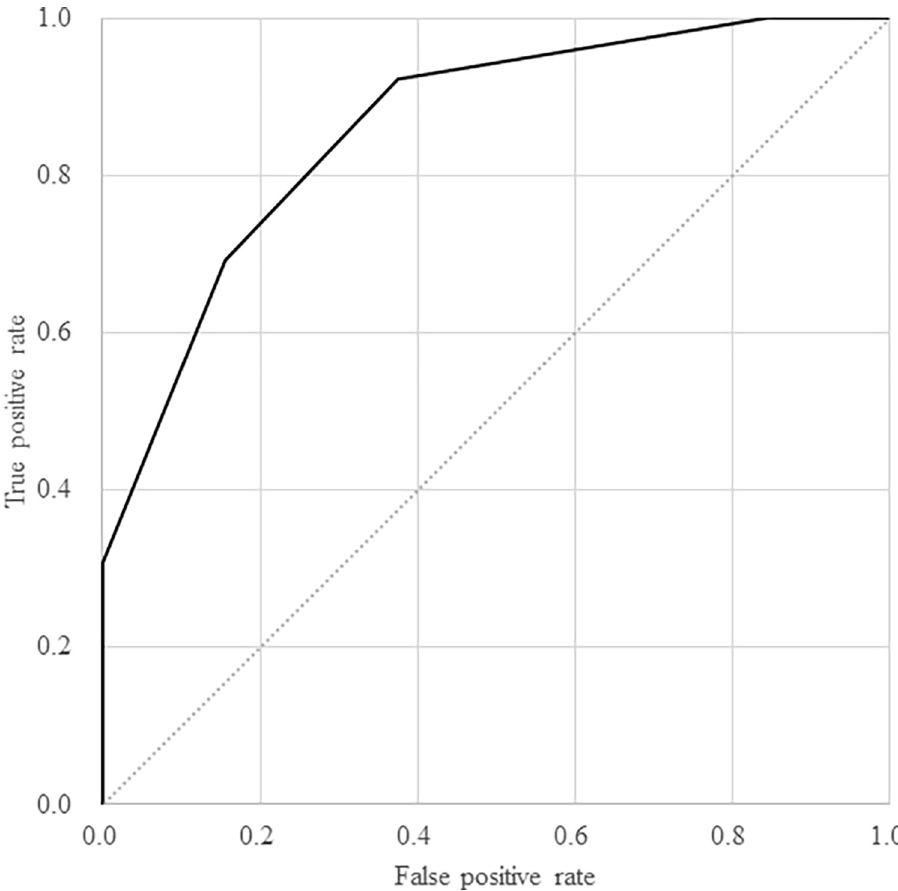
Fig 4. Predictive ability for mechanical ventilation administration or death in patients with oxygen support except mechanical ventilation within 4 days after starting the oxygen supply by the number of positive results of the four biomarkers (Study